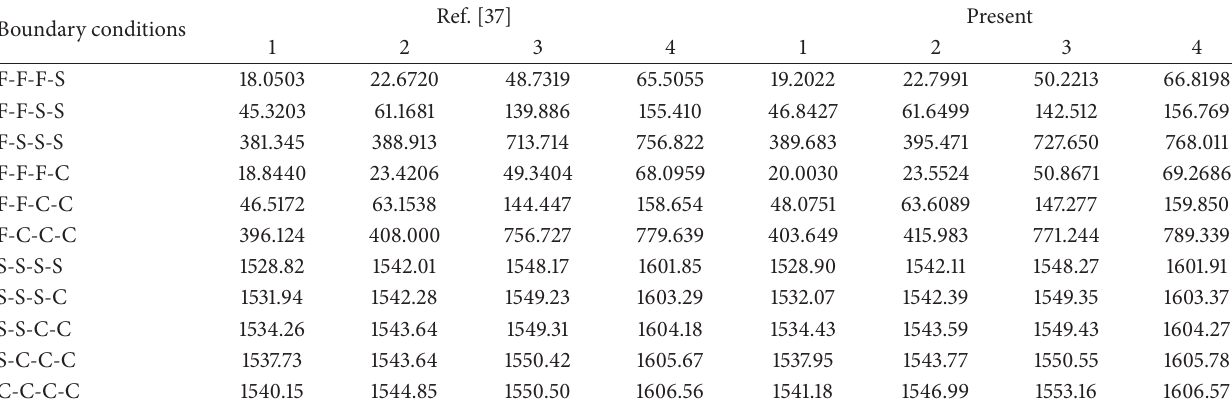
Table 12: First four frequency parameters Ω = 𝜔𝐿 2 √𝜌ℎ/𝐷 for an open spherical shell with various boundary conditions. Ref. Boundary conditions